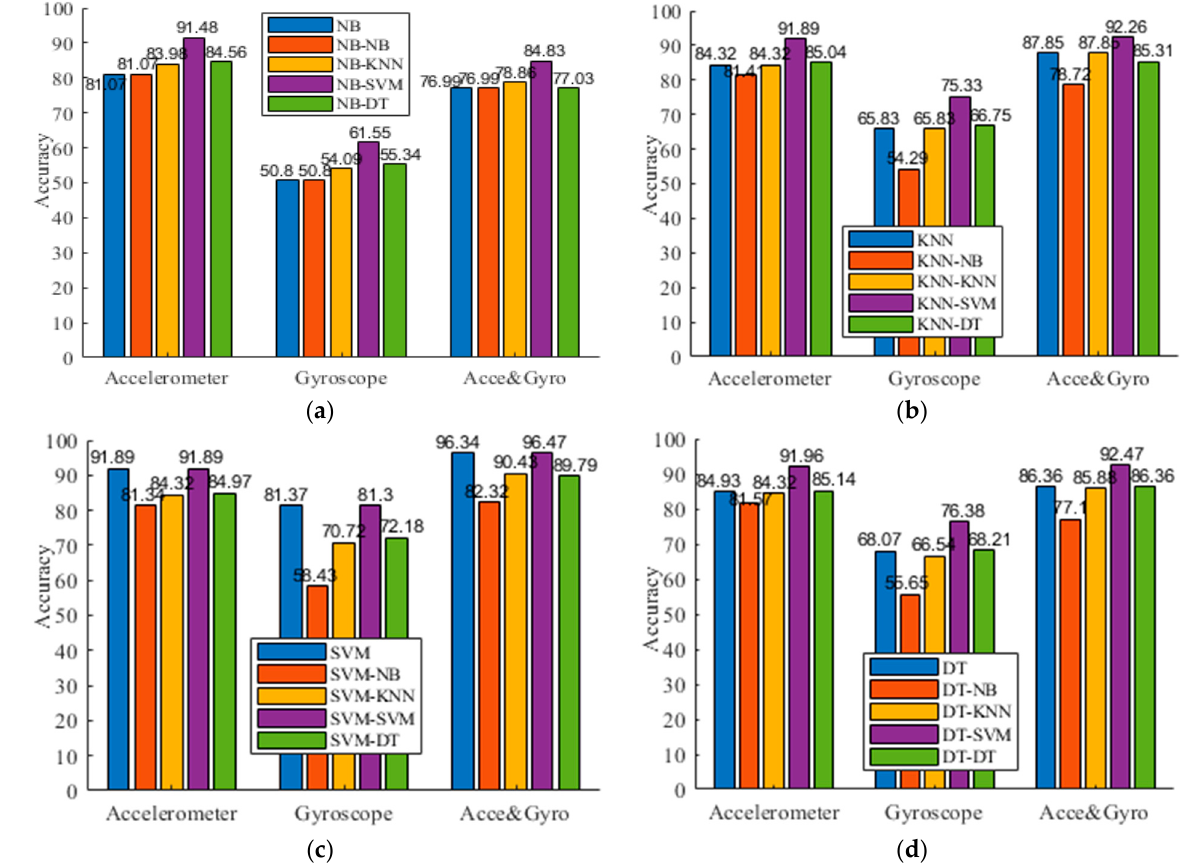
Figure 3. Accuracy comparisons on the three datasets. ( a ) NB; ( b ) KNN; ( c ) SVM; ( d ) DT. Table 3. Recognition performance on the Accelerometer dataset.